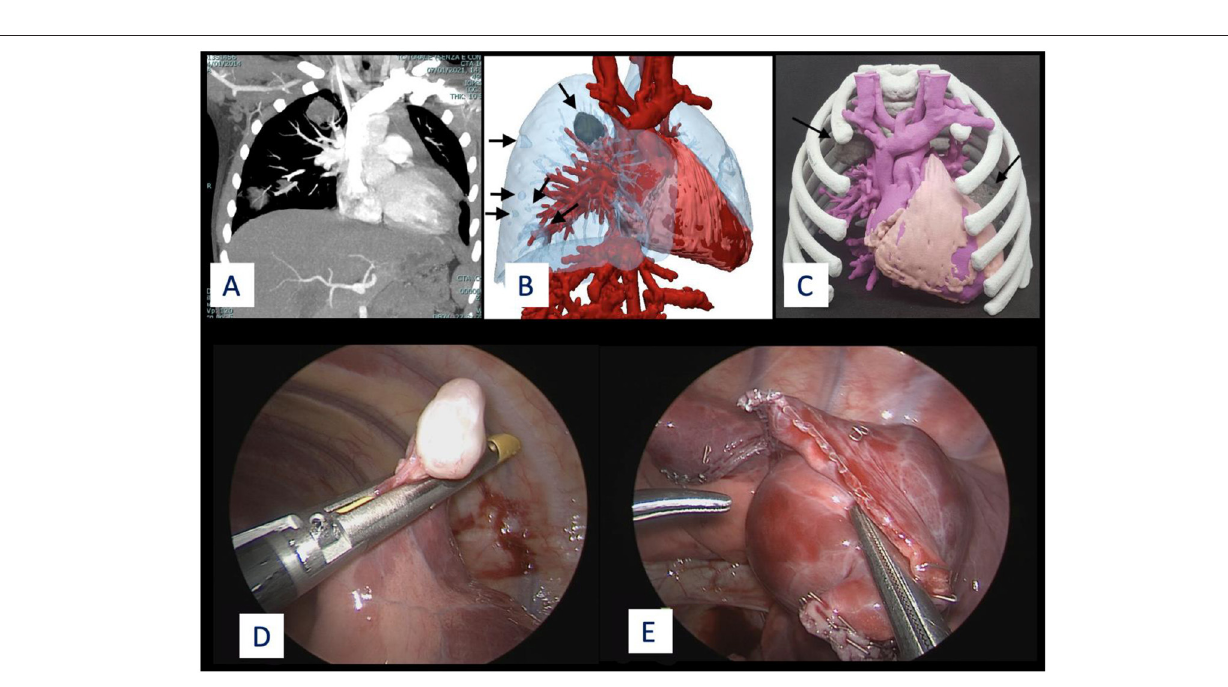
FIGURE 3 | Multiple metastases of immature teratoma in a 7-year-old girl. Left single metastasis was excised through an open procedure, due to dimension and site of the mass. The remaining lesions ( n = 6, one solid, five cystic ones) on the right lobe were excised through VATS. (A) CT image. (B) 3D virtual reconstruction. (C) 3D printed model showing the two solid lesions (colored in gray). (D,E) Intraoperative